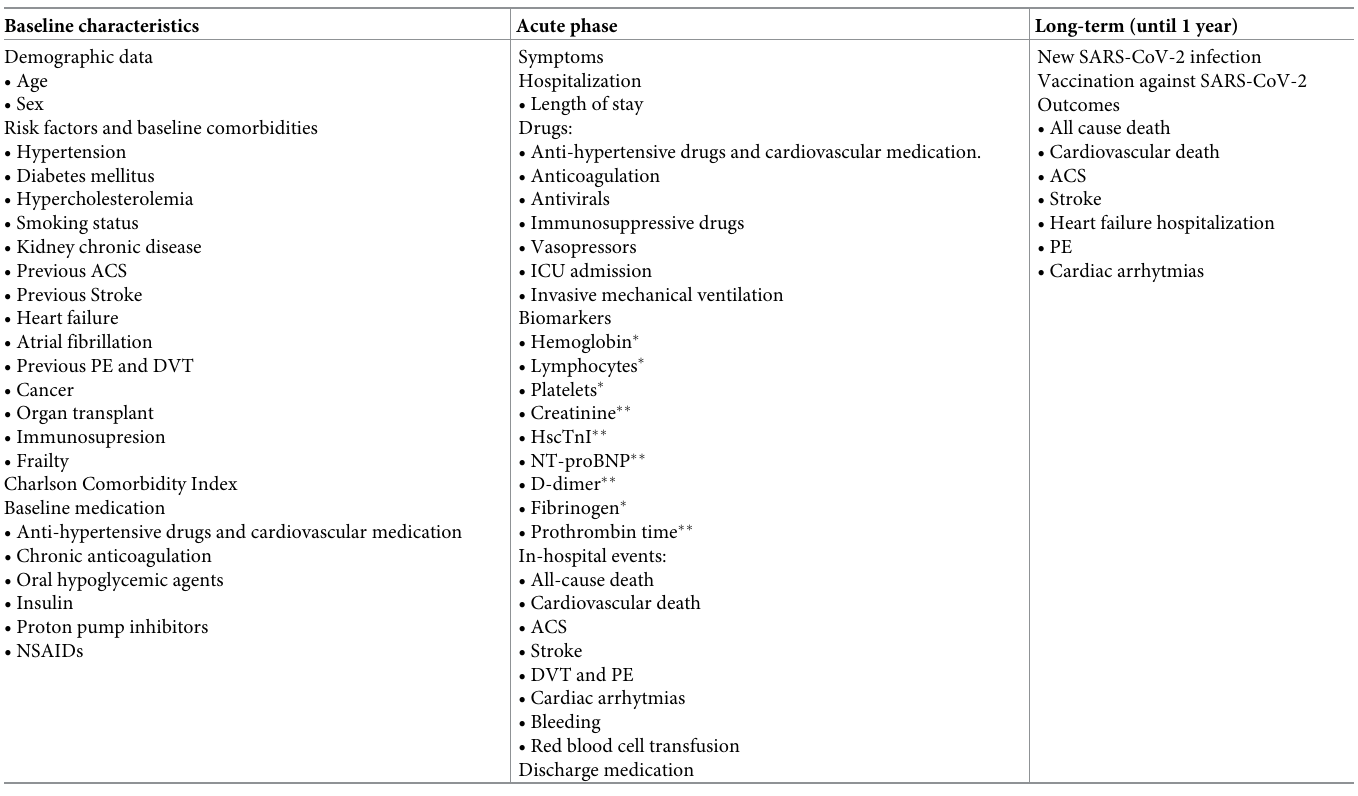
Table 2. Data to be obtained in the timeline of the